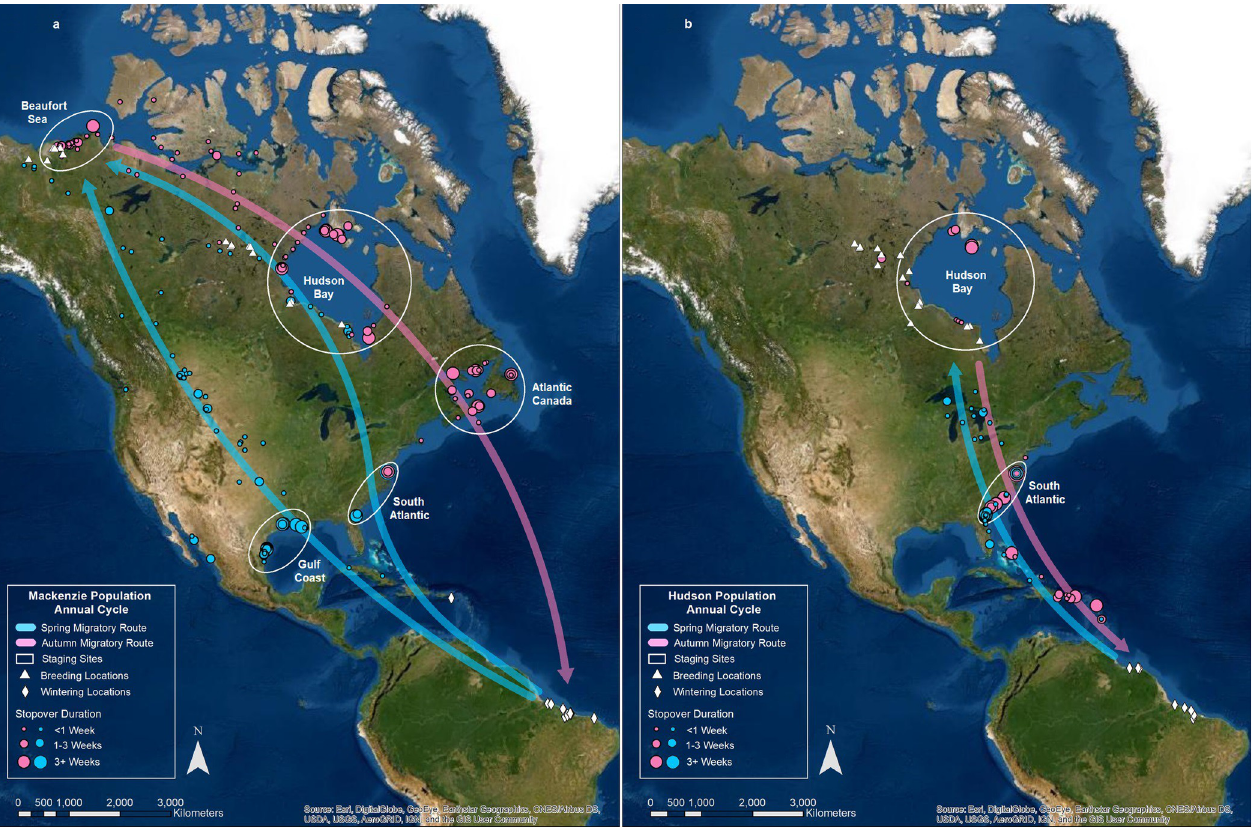
Fig 1. Stylized, Composite Maps of The Annual Cycle for the Mackenzie Delta (1a) and the Hudson Bay (1b) Whimbrel Populations. Information represents a synthesis of multiple years of tracking data. Dots and diamonds represent centroids of locations from periods when birds were not flying. Figure was created by one of the authors using ArcGIS 10.4.1. Basemap provided by: ESRI, Digital Globe, GeoEye, Earthstar Geographics, CNES/Airbus DS, USDA, USGS, AeroGRID, IGN, and the GIS User Community.